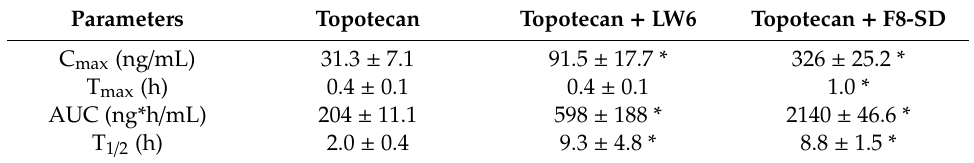
* p < 0.05, compared to the control given topotecan